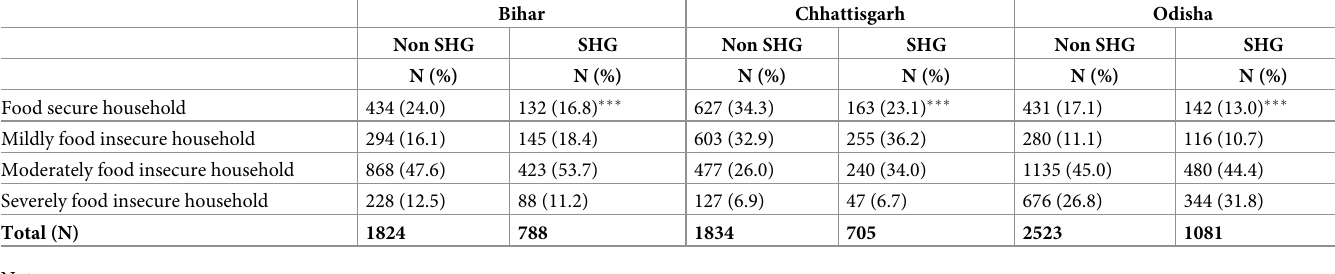
Table 7. Household food security among SHG and non-SHG member mothers of children under two years in Bihar, Chhattisgarh and Odisha.